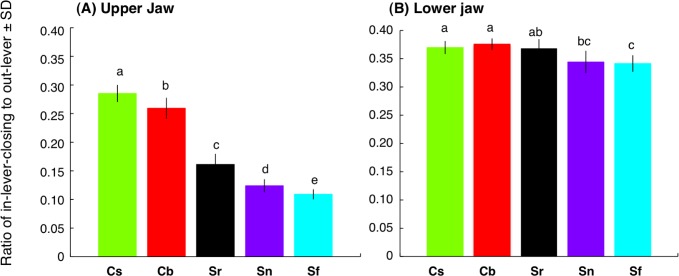
Interspecific difference in the ratio of in-lever-closing to out-lever (Lin-lever-closing/ Lout-lever) (see also Fig. 3) for upper jaw (A) and lower jaw (B).The greater values in the ratio means higher force but lower velocity, whereas lower values in the ratio means higher velocity but lower force (Westneat, 2004). Different alphabet characters on the bars indicate significant difference (one-way ANOVA and post-hoc Games- Howell test, p < 0.05). Species names are abbreviated as Cs, Chlorurus sordidus; Cb, C. bowersi; Sr, Scarus rivulatus; Sn, S. niger; Sf, S. forsteni.